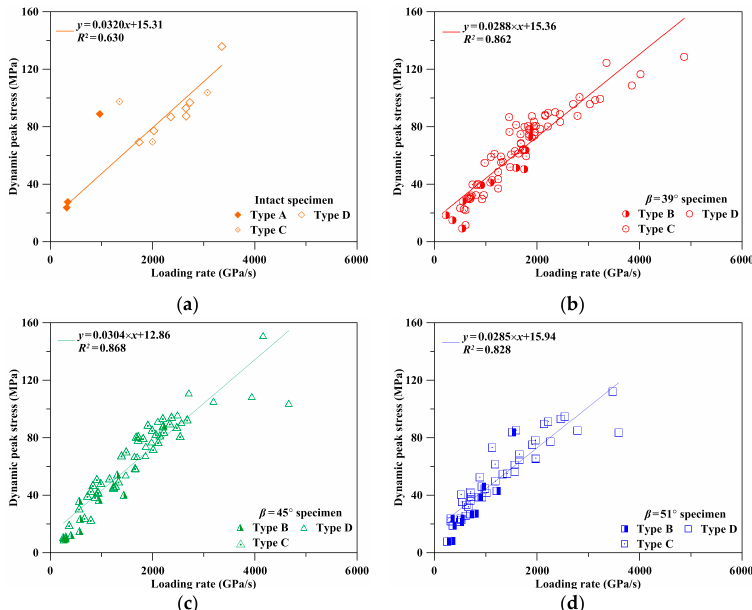
Figure 8. Relationship between dynamic peak stress/strength and loading rate of intact specimen ( a ) and all jointed specimens with β = 39°, 45°, and 51° ( b – d ).